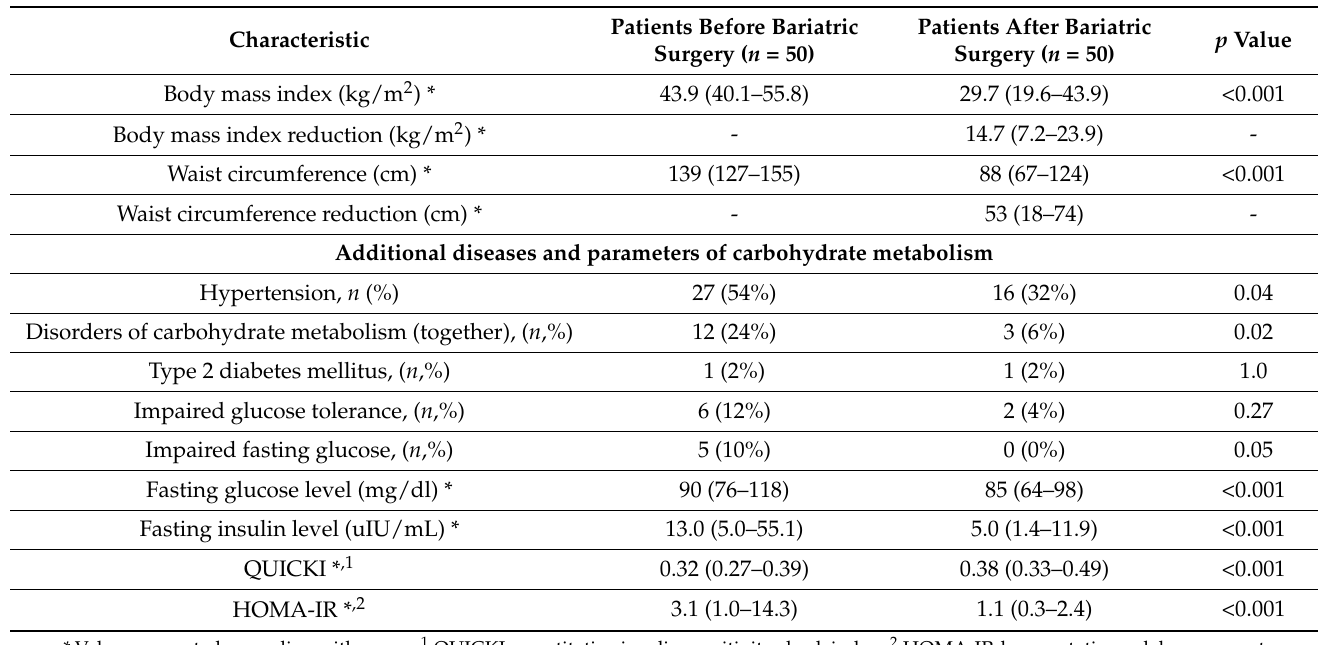
Table 2. Anthropometric obesity parameters, additional diseases and parameters of carbohydrate metabolism results in patients before and after bariatric